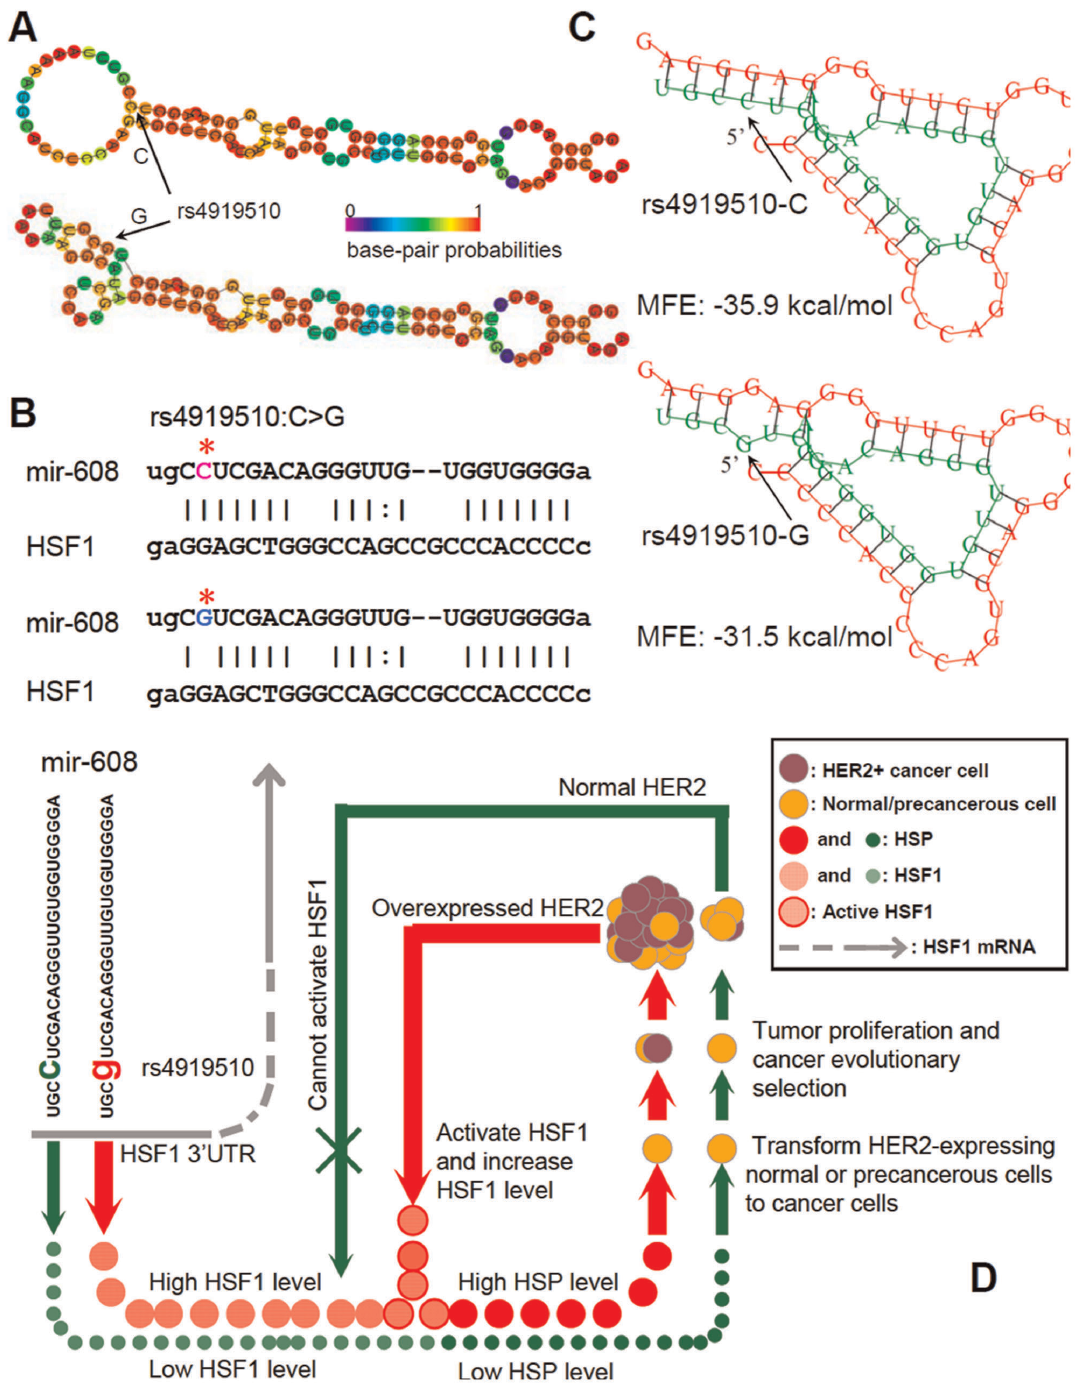
Figure 1. Bioinformatics prediction of rs4919510 within miR-608 and schematic representation of potential pathological mechanism of rs4919510 in HER2-positive breast cancer development. A, the predicted secondary structure of human miR-608 stem-loop sequence (100 bp) by RNAfold, with either the C- allele or G-allele. For ancestral form with C-allele, the optimal secondary structure with a minimum free energy (MFE) of 2 32.20 kcal/mol. The frequency of the MFE structure in the ensemble is 0.53%, and the ensemble diversity is 13.52. For the variant form, the optimal secondary structure with the same MFE of 2 32.20 kcal/mol. The frequency of the MFE structure is 0.33%, and the ensemble diversity is 14.09. The structure plot shows that variant G-allele strongly interfere with loop forming. B, HSF1 is a predicted target of miR-608 and rs4919510:C . G is just located at the complementary sequence. Asterisk indicates the polymorphic site. The plot of predicted duplex formation is from MicroCosm Targets website. C, Predicted secondary structure of duplex formation between miR-608 and 3 9 UTR of HSF1 by RNAhybrid. rs4919510:C . G changes the MFE, with ancestral form of 2 35.9 kcal/mol and variant form of 2 31.5 kcal/mol. D, schematic representation of speculated pathological mechanism of rs4919510 in HER2-positive breast cancer development. In this model, miR-608 harbouring the rs4919510-C allele (ancestral form) is set as the baseline condition. The C-to-G substitution might weaken the suppression of HSF1 mRNA by miR-608, leading to relatively high expression of HSF1 protein and, in turn, up-regulating HSPs and facilitating HER2-expressing normal or precancerous breast cells to